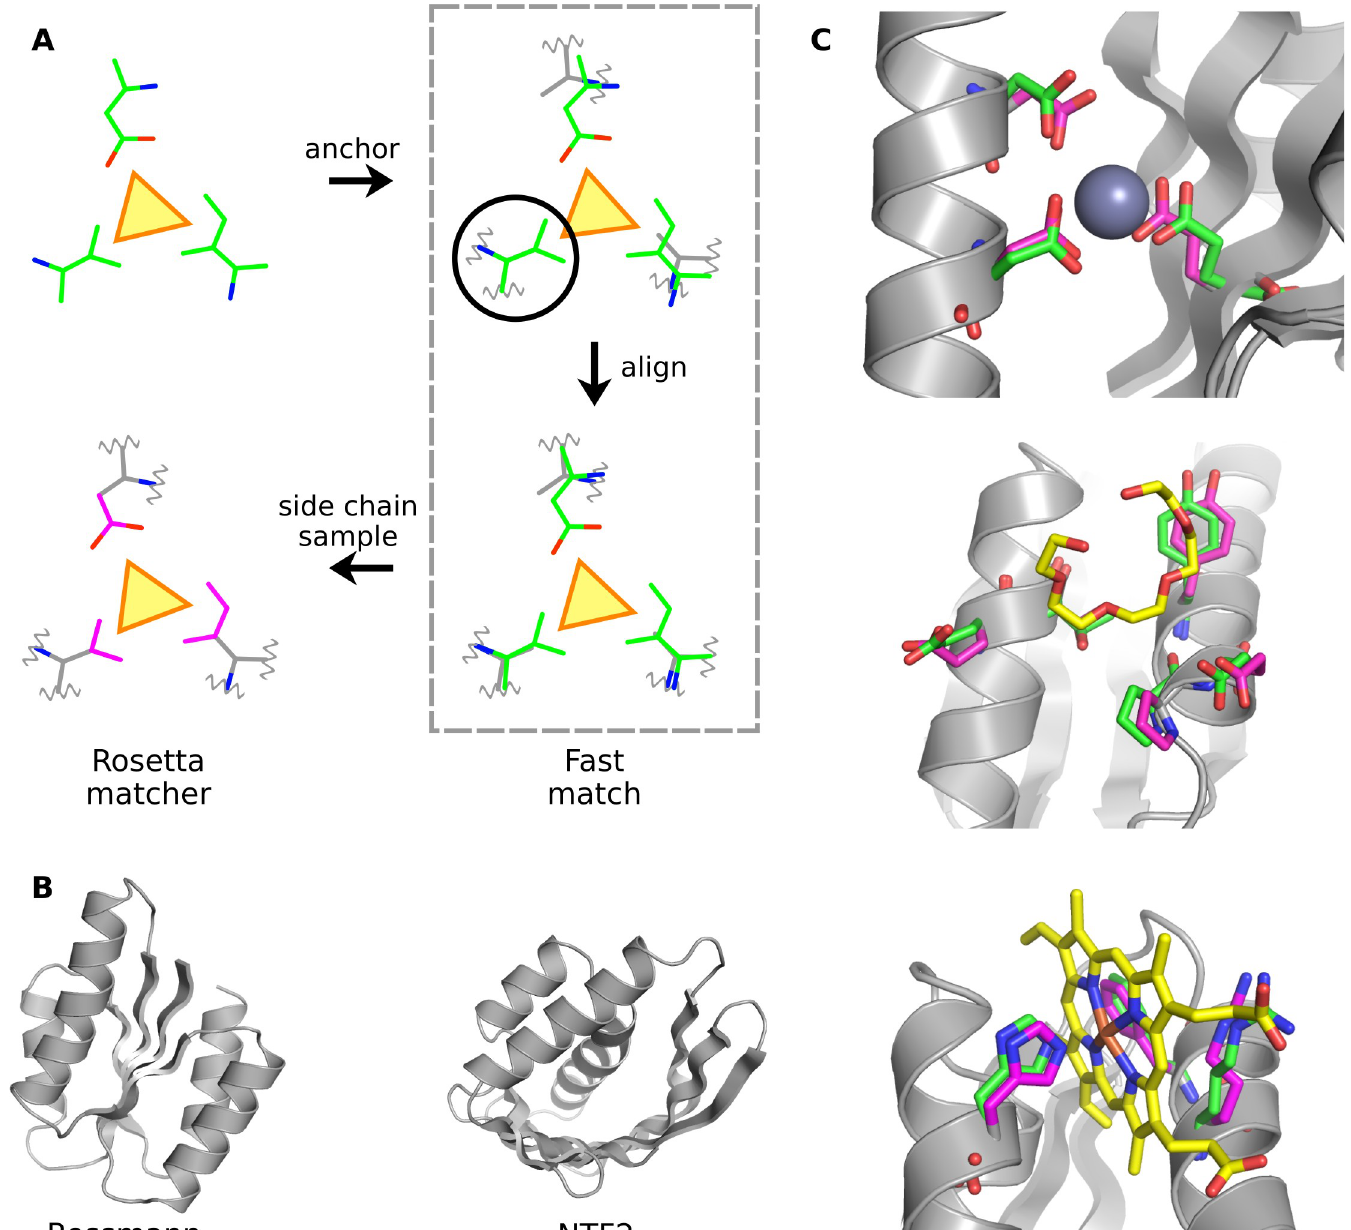
Fig 2. Matching ligand binding sites to scaffold libraries. A. Schematic of the matching protocol. The ligand is represented as a yellow triangle. The ligand-binding site as a rigid body (green) is first matched to the scaffold (grey) by anchoring to a scaffold residue shown in the black circle. Then the binding site residues are aligned to the corresponding scaffold residues. Finally, the standard Rosetta matcher is applied to build the binding site side chains (magenta) onto the scaffold. B. The binding sites are matched to native and de novo designed scaffold families with Rossmann or NTF2 fold topologies. C. Examples of matches. The coloring scheme is the same as A .